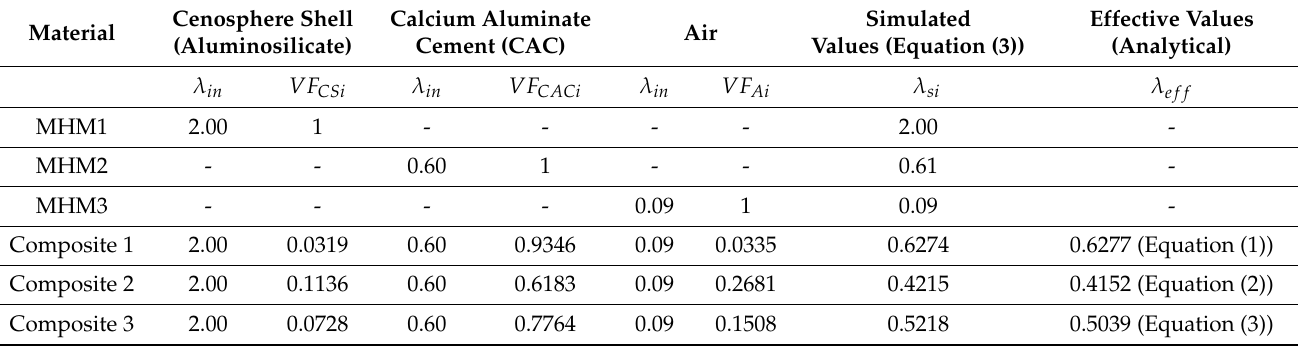
Table 3. Thermal conductivity λ in , λ si , and λ ef f , and volume fraction ( VF i = V i / V ) at 1400